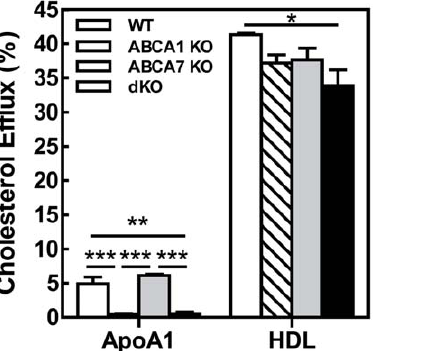
Figure 5. Effect of macrophage ABCA1, ABCA7, and combined ABCA1/ABCA7 deficiency on cellular cholesterol efflux. Thio- glycollate-elicited peritoneal macrophages were isolated from male recipients at 18 weeks posttransplant. Cholesterol efflux from 3 H- cholesterol-labeled cells incubated with DMEM/0.2% BSA alone or supplemented with either 10 m g/mL apoA-I or 50 m g/mL human HDL was determined after 24 hours of incubation. Results are the mean 6- SEM of 4 mice per group. Statistically significant difference *p , 0.05.